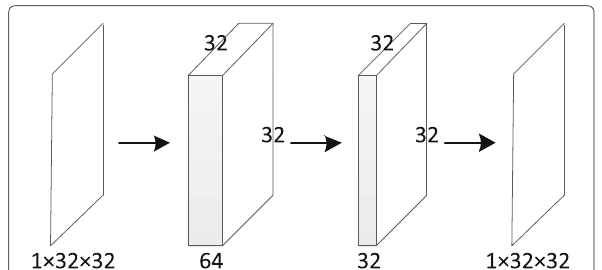
Fig. 2 The framework of deep reconstruction